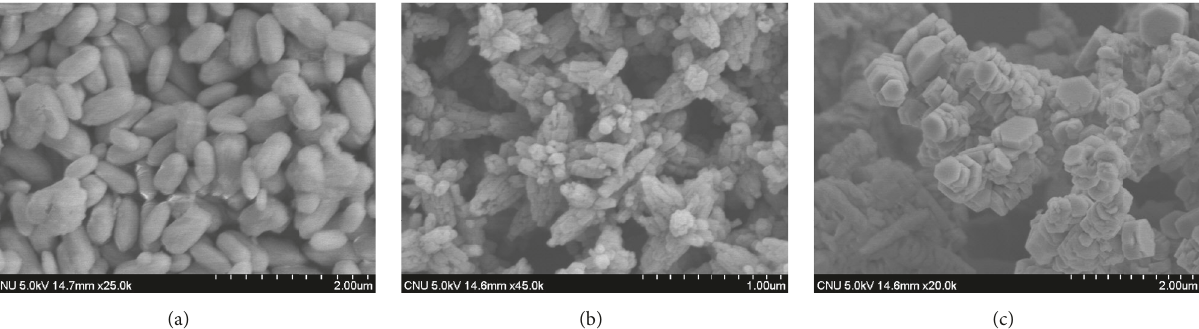
Figure 4: Typical FESEM images of ZnO nanostructures grown with SDS polymer (0.1g) and different NH 4 OH concentrations of (a) 0.1 ml, (b) 1.0ml, and (c) 2.0 ml and growth temperature and growth time of 150 ∘ C and 10 hours, respectively.